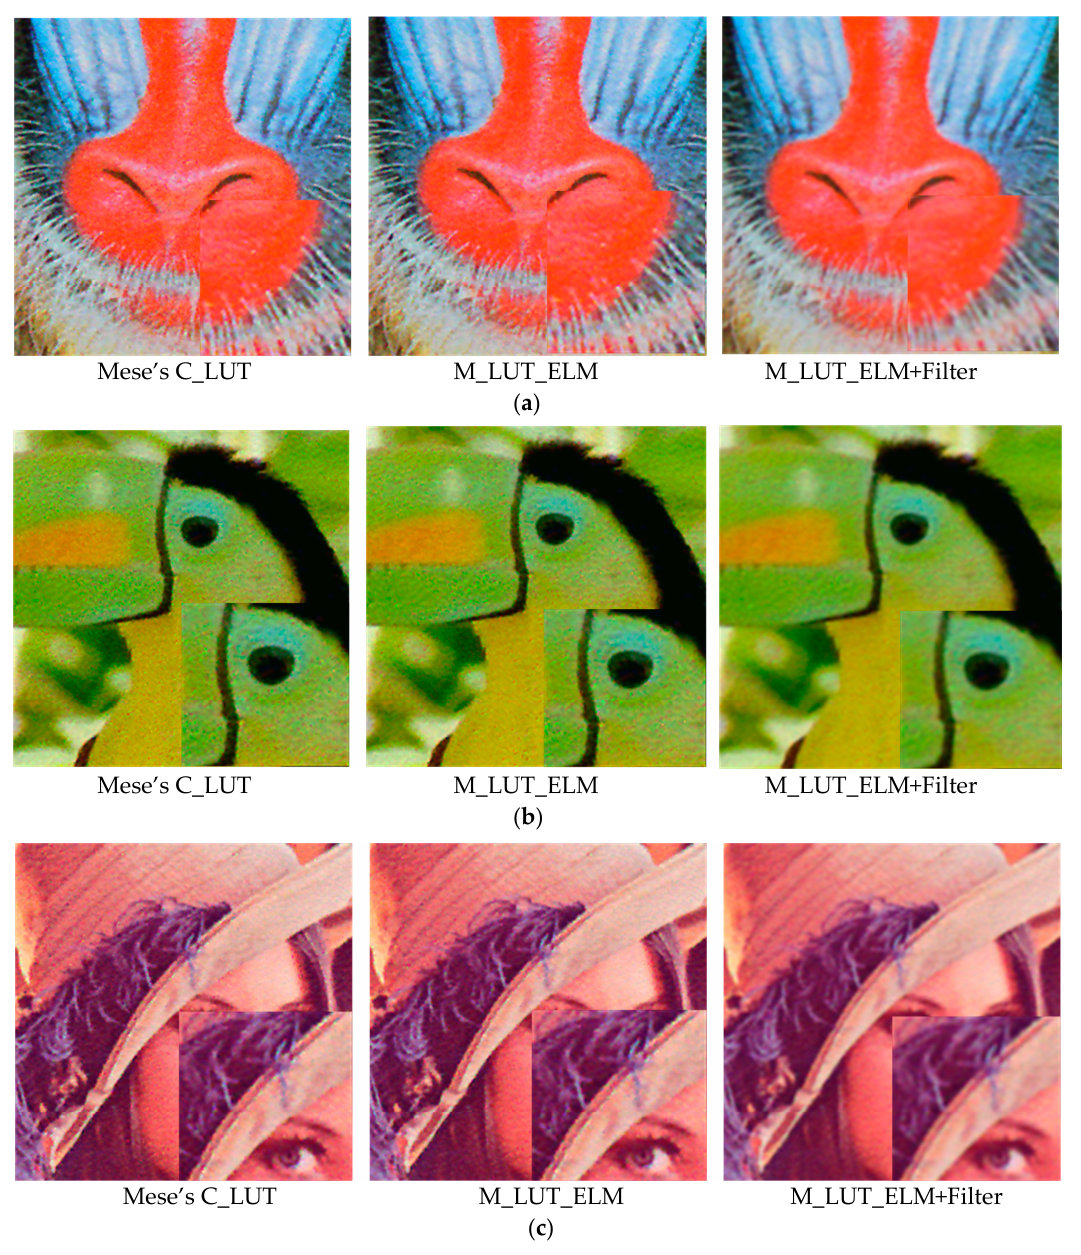
Figure 6. Inverse halftoning performance comparison with Mese’s C_LUT, M_LUT_ELM and M_LUT_ELM + filter. ( a ) baboon color image, ( b ) parrot color image, ( c ) Lena color image.